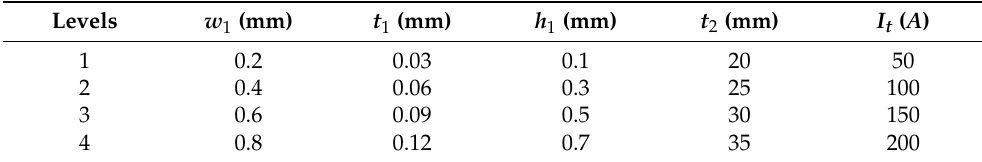
Table 2. Ranges of variation of EMAT parameters.